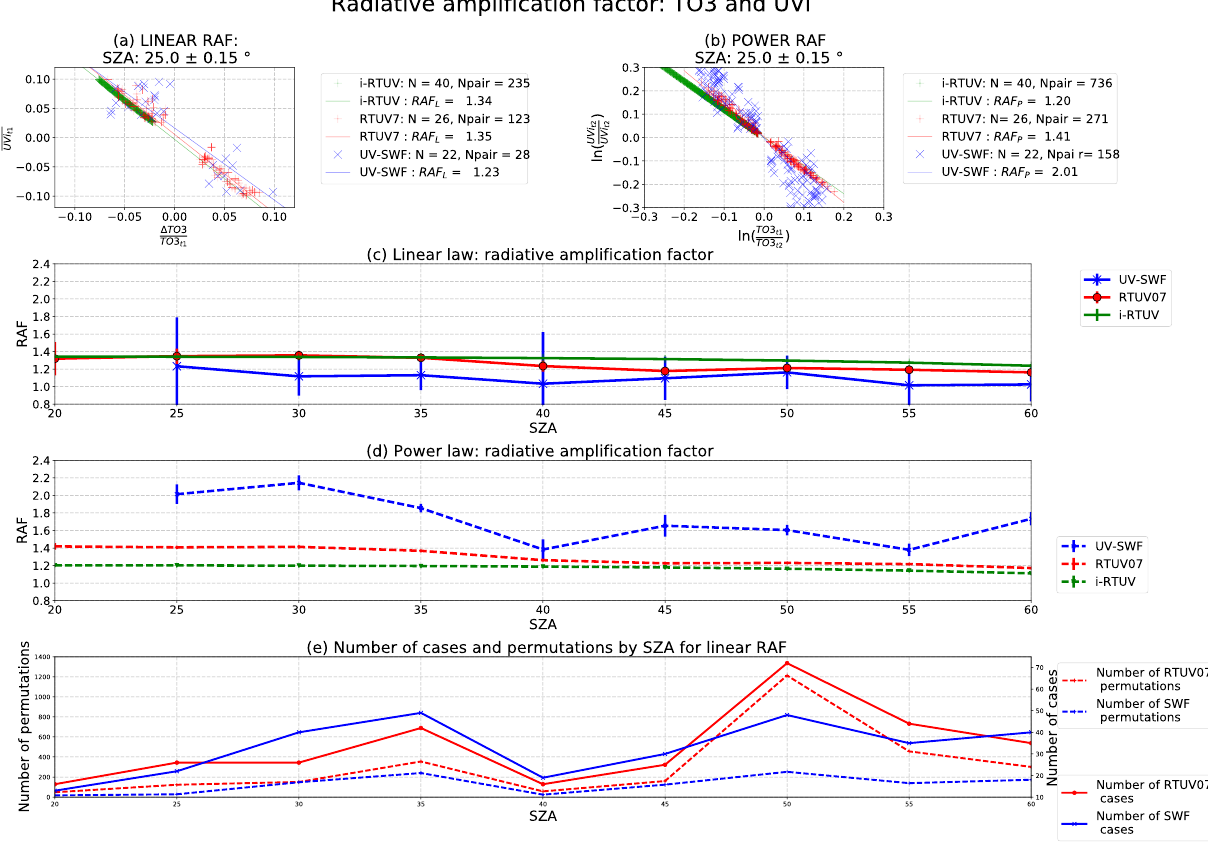
Figure 8. Radiative amplification factor. (a) (cid:49) UV / UV versus (cid:49) TO 3 / TO 3 for UV-SWF (blue crosses), RTUV07 (red crosses) and i-RTUV (green crosses). Linear fitted functions are in coloured curves of corresponding colours. (b) Same as panel (a) but for a power-law fit between ln ( UV / UV t 1 ) and ln ( O3 / O3 t 1 ) . (c, d) Linear and power RAFs deduced from the previous fit for a varying SZA with a 2 σ dispersion bar. (e) Number of permutations ( N pair ) and number of cases ( N ) available in comparison to SZA for the linear RAF.